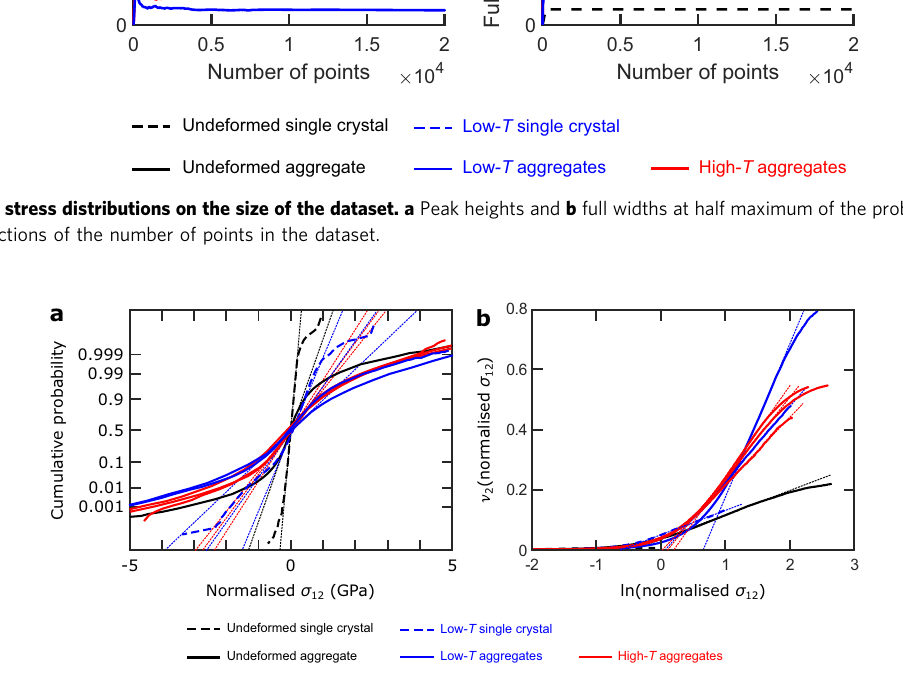
Fig. 4 Analysis of the form of the stress distributions. a Normal probability plot of normalised σ 12 . On this plot, the cumulative probability axis is scaled such that normal distributions fall on a straight line (indicated as fi ne dotted lines for visual guides), therefore, deviations from straight lines indicate departures from normal distributions. Solid and dashed lines are calculated from HR-EBSD data. b Restricted second moments ( ν 2 ) of the normalised σ 12 probability distributions. On this plot, straight lines (indicated as fi ne dotted lines for visual guides) indicate that probability P ( σ 12 ) ∝ | σ 12 | − 3 , as expected of stress fi elds generated by dislocations 44 – 47 . Solid and dashed lines are calculated from HR-EBSD data.